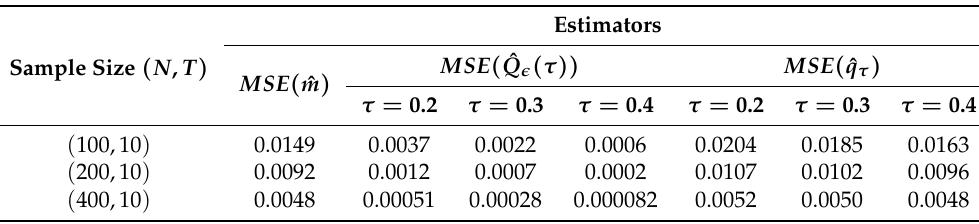
Figure 1. Recovered densities across different bandwidths and homoskedastic symmetric normal errors. Table 1. Mean MSE ( × 100), N ( 0,1 ) Errors.